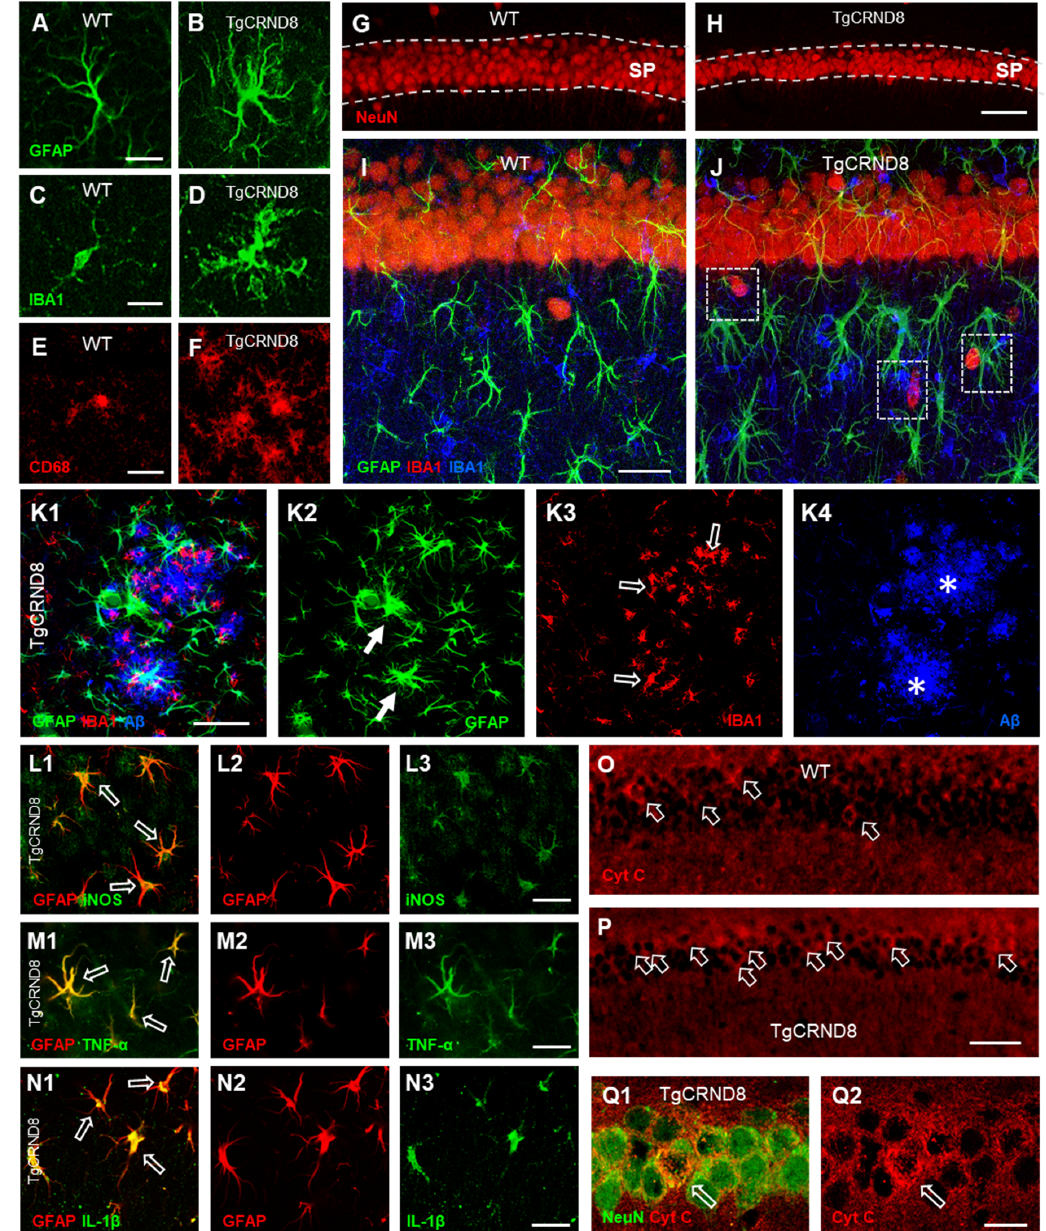
Figure 1. ( A , B ) Representative confocal photomicrographs of GFAP immunostaining of an astrocyte (green) in CA1 SR of a WT ( A ) and a TgCRND8 mouse ( B ). Scale bar: 15 µm. (C , D) : representative confocal photomicrographs of IBA1 immunostaining of microglia (green) in CA1 of a WT ( C ) and a TgCRND8 mouse ( D ). Scale bar: 20 µm. ( E , F ): Representative confocal photomicrographs of CD68 immunostaining of reactive microglia (red) in CA1 SR of a WT ( E ) and a TgCRND8 mouse ( F ). Scale bar: 20 µm. ( G , H ) Representative confocal photomicrographs of NeuN immunostaining of neurons (red) in CA1 SP of a WT ( G ) and a TgCRND8 mouse ( H ). Scale bar: 60 µm. ( I , J ) Representative confocal photomicrographs of triple immunostaining of neurons (NeuN, red), astrocytes (GFAP, green), and microglia (IBA1, blue) in the CA1 SR of a WT ( I ) and of TgCRND8 mouse ( J ). Neuron– astrocyte–microglia triads are evidenced in ( J ) (framed areas). Scale bar: 40 µm. ( K1–K4 ):